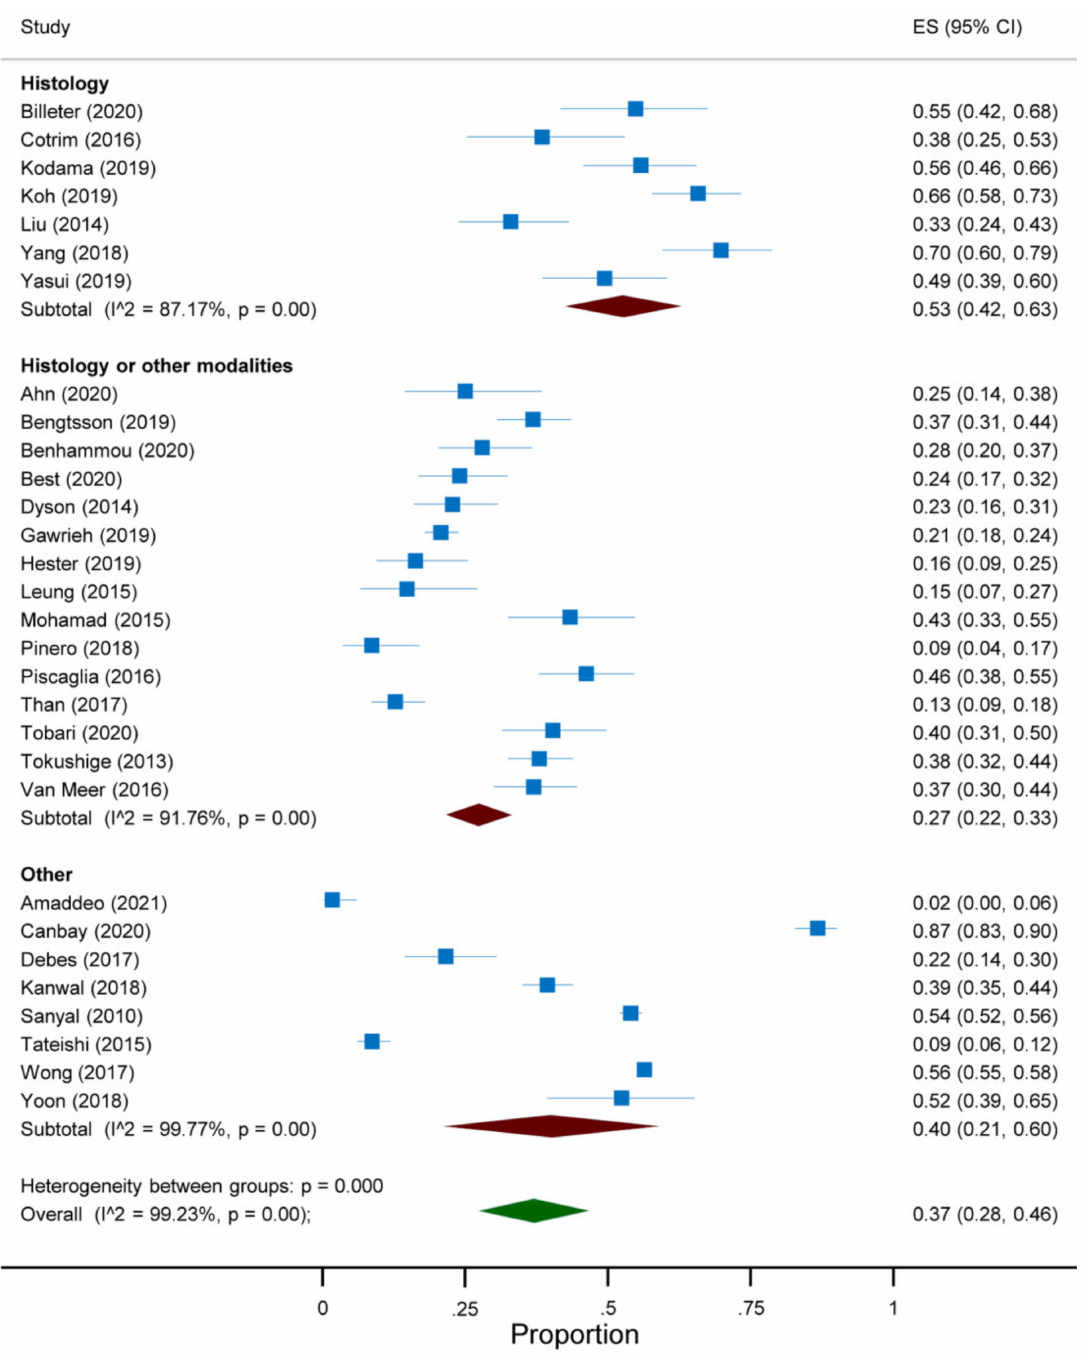
Figure 4. Forest plot of the absence of cirrhosis in subjects with NAFLD-associated HCC according to the reference standard for the diagnosis of